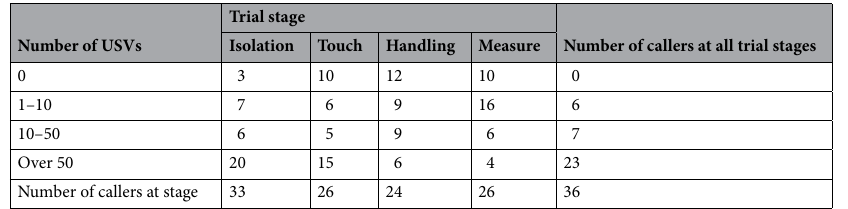
Table 1. Numbers of USV callers with different vocal activity which provided USVs at different stages of the 36 experimental trials (one trial per animal).